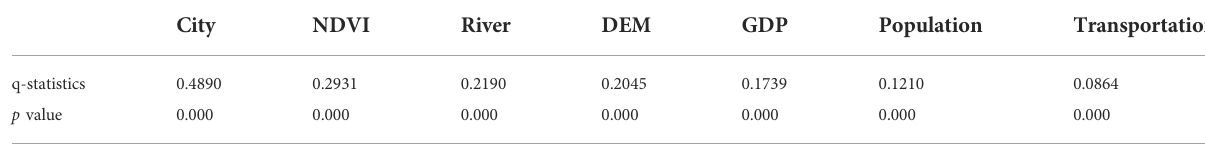
TABLE 3 Q-statistics table for the correlations between the various factors and the spatial distribution of scenic spots in Northwest China based on geographic detectors (scale size: county scope). City NDVI River GDP